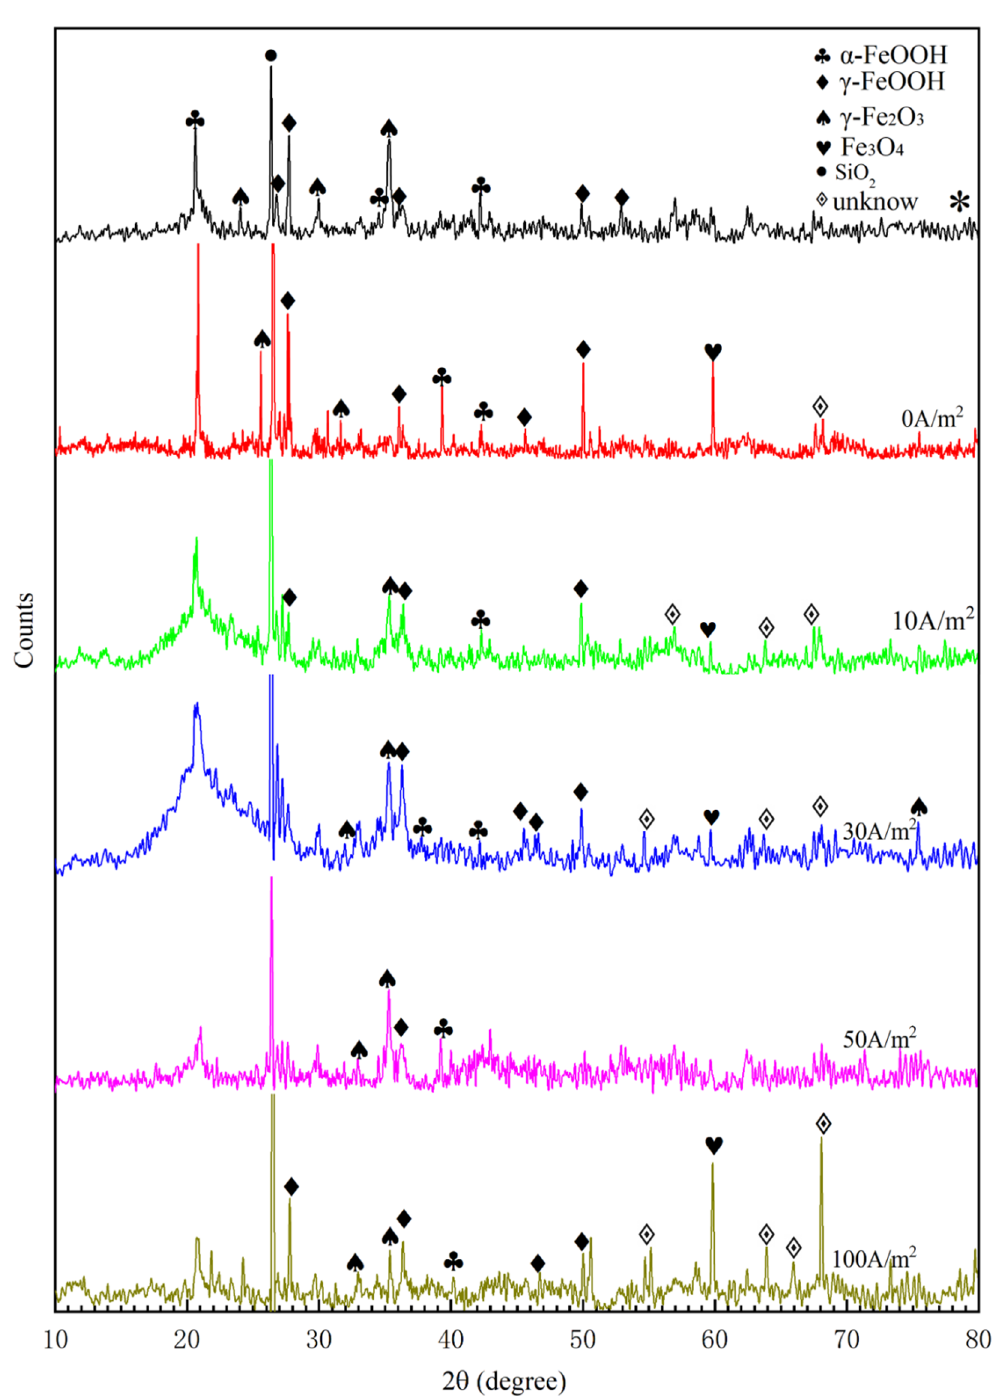
Figure 7. XRD patterns of products formed on the steel. * represents single steel sample without AC interference.